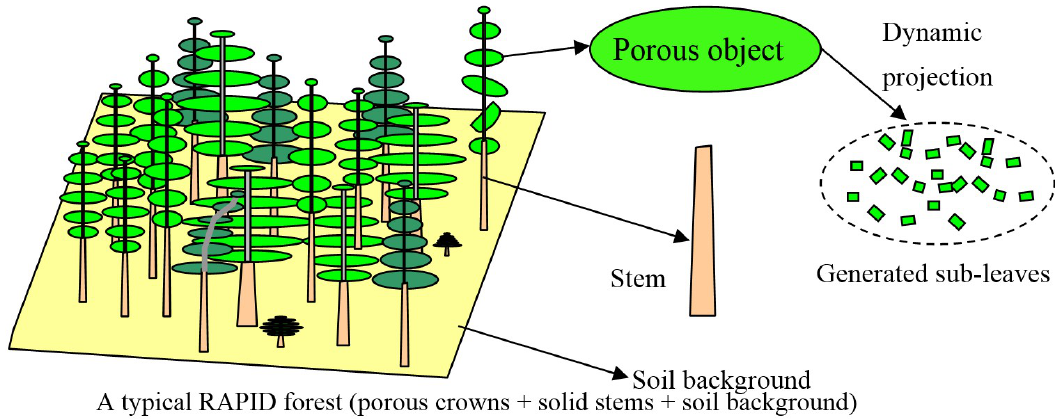
Figure 1. A typical 3D forest scene defined in RAPID [16]; each tree is represented by porous crowns, solid stems and soil polygons; each crown is composed of a few porous objects, which look similar to planar objects but will be dynamically projected into sub-leaves during runtime.